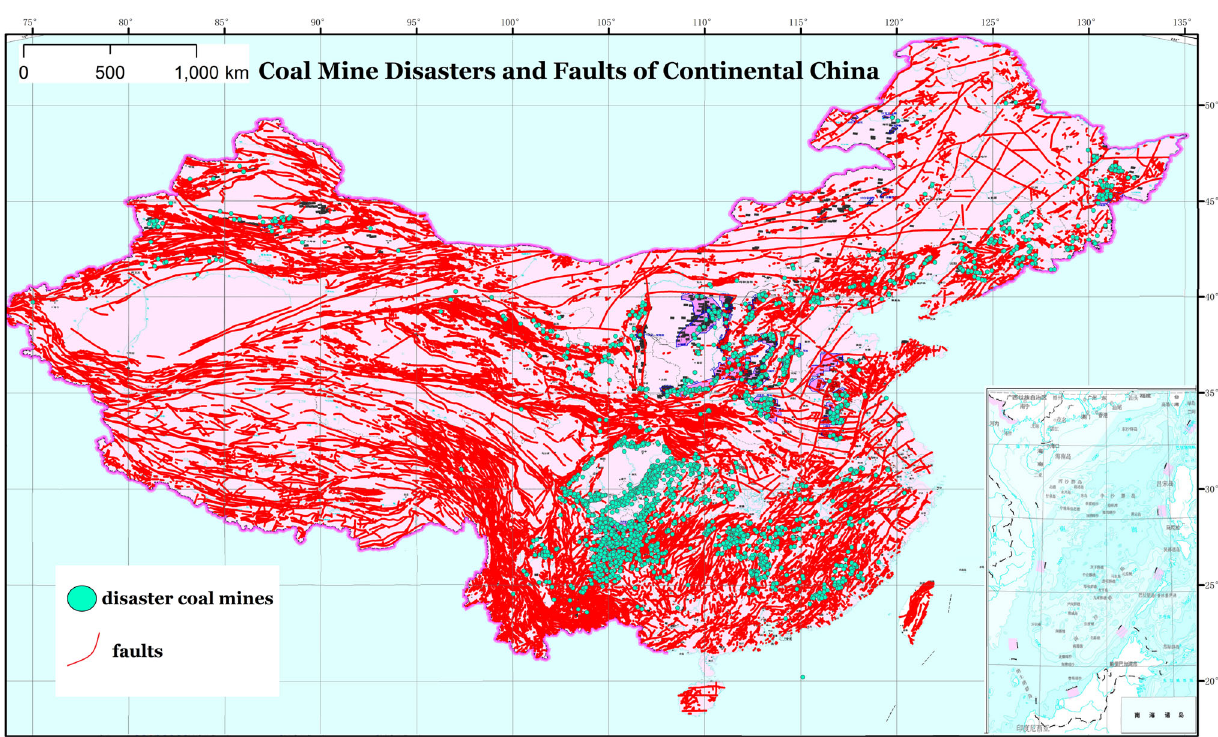
Fig. 16 Map of coal mine disasters and faults in continental China, combining the following data: 1. 1 : 10,000,000 Chinese Coal Resource Distribution Map (Chinese Geological Survey 2020); 2. 1 : 2,500,000 Chinese Metallogenic Domain Map (Geological and National Digital Data Center 2020); 3. Chinese Coal Mine Disaster Records (Chinese Coal Mine Safety Administration